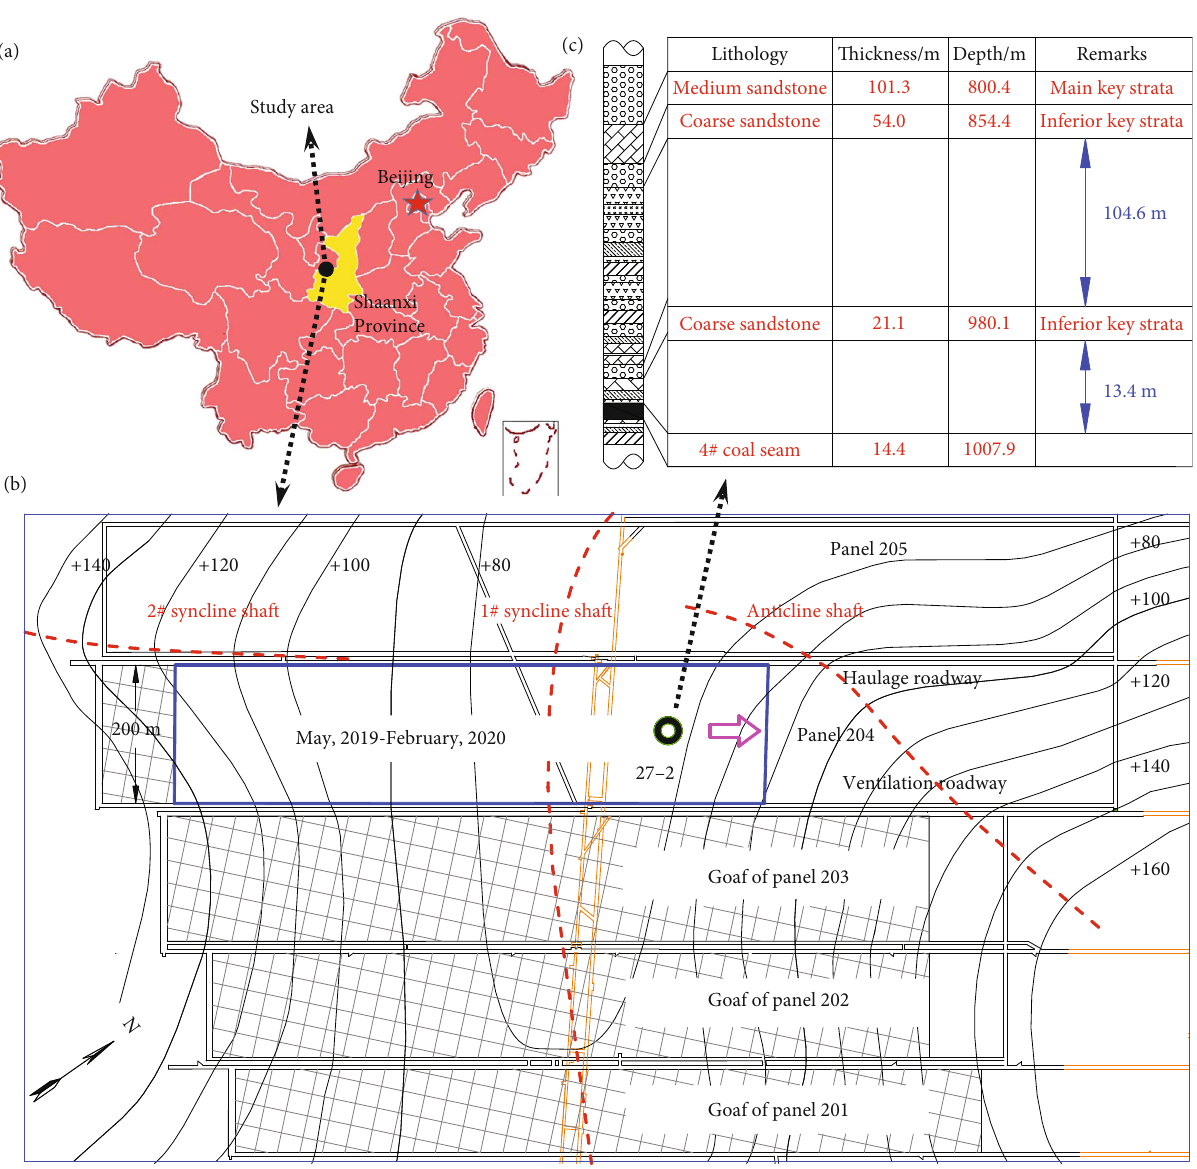
Figure 2: Mining conditions. (a) Location of coal mine. (b) Layout of panel 204. (c) Stratigraphic column of bore